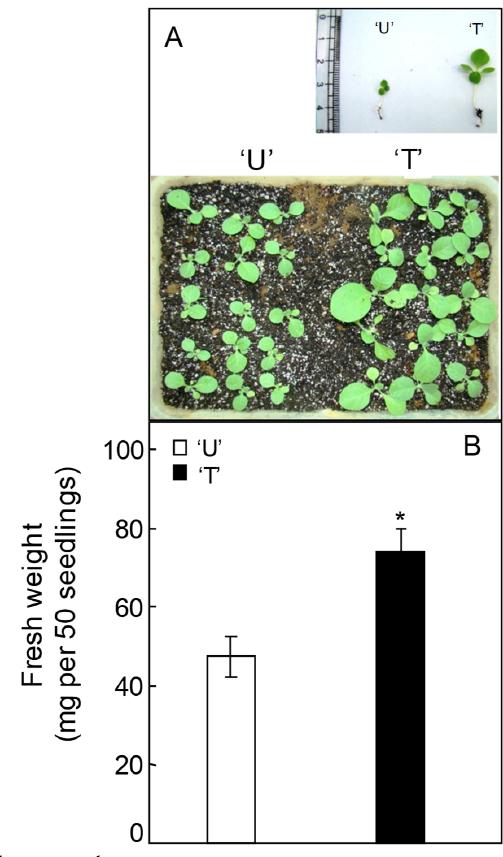
Figure 1. Tobacco seedlings growth measurement A. Representative image of ‘U’ and ‘T’ at the end of test-period (28 th day post-treatment), wherein inset depicts the individual ‘U’ and ‘T’ plantlet. B. Fresh weight of ‘U’ and ‘T’ at the end of test-period. For seedlings weight measurement, 50 seedlings per biological replicate were used. Means ± SDs, n = 3, wherein * indicate the significant differences ( p ≤ 0.05 ). ‘U’- Untreated and ‘T’ - GA 3 treated